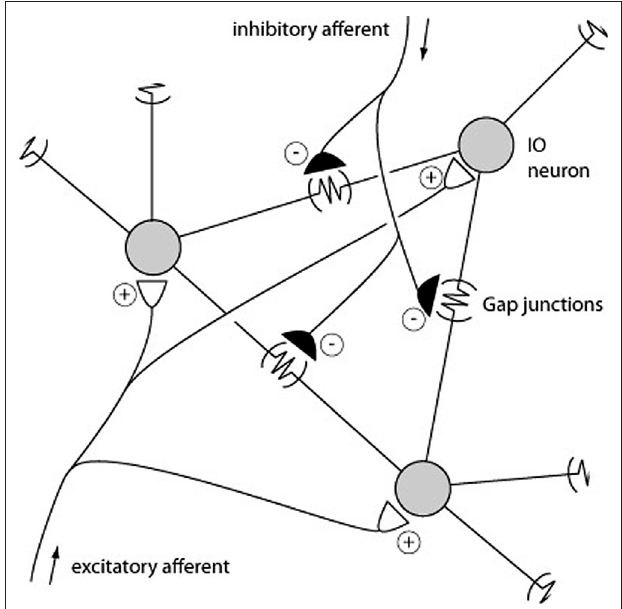
FIGURE 5 | Schematic description of mechanisms that could promote CF synchrony. Three IO neurons and their gap junction couplings are illustrated. ‘Half’ junctions extending towards the outer edges indicate that the gap junction couplings include additional IO neurons that are not depicted. Also illustrated are the excitatory and inhibitory afferents. Some inhibitory afferents terminate specifi cally on the sites of gap junctions (De Zeeuw et al.,